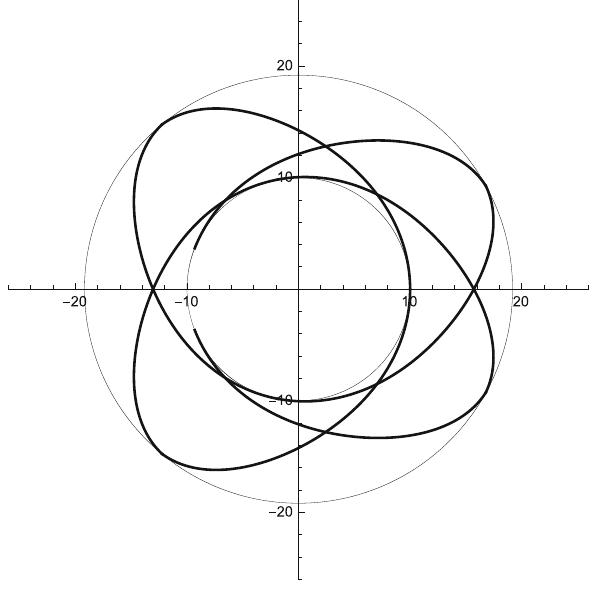
Fig. 4 The planetary orbit for L = 10, r A = 19 . 185, r P = 10 and E = 1 .